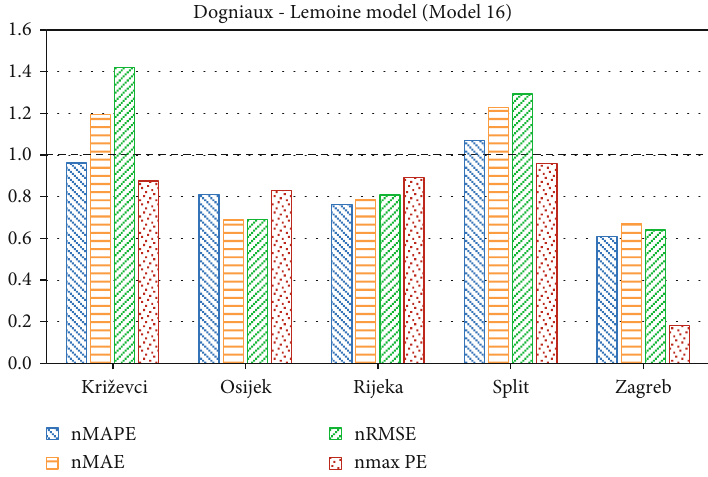
Figure 9: Comparison of statistical parameters (MAPE, MAE, RMSE, and max PE) for the Dogniaux-Lemoine monthly dependent model based on the data from fi ve stations (Kri ž evci, Osijek, Rijeka, Split, and Zagreb). All parameters are shown as relative values adjusted to the original